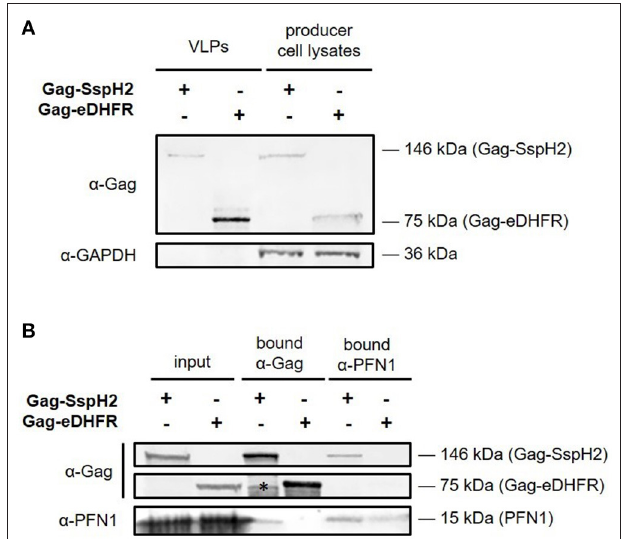
FIGURE 3 | Western blot analysis of Gag-SspH2 virus-like particles and interaction with profilin. Virotrap control Gag-eDHFR and S. Typhimurium effector Gag-SspH2 fusion was co-expressed with FLAG-tagged vesicular stomatitis virus glycoprotein (VSV-G) in HEK293T cells. (A) For both setups, virus-like particles (VLPs) were captured from the cell medium using anti-FLAG immunoprecipitation. VLP lysates loaded on gel represent a 20-fold equivalent of the producer cell lysate loaded. (B) Reciprocal co-immunoprecipitation was done with producer cell lysates of cells expressing Gag-eDHFR and Gag-SspH2 using anti-Gag and anti-PFN1 antibodies. The asterisk indicates a non-specific/degradation